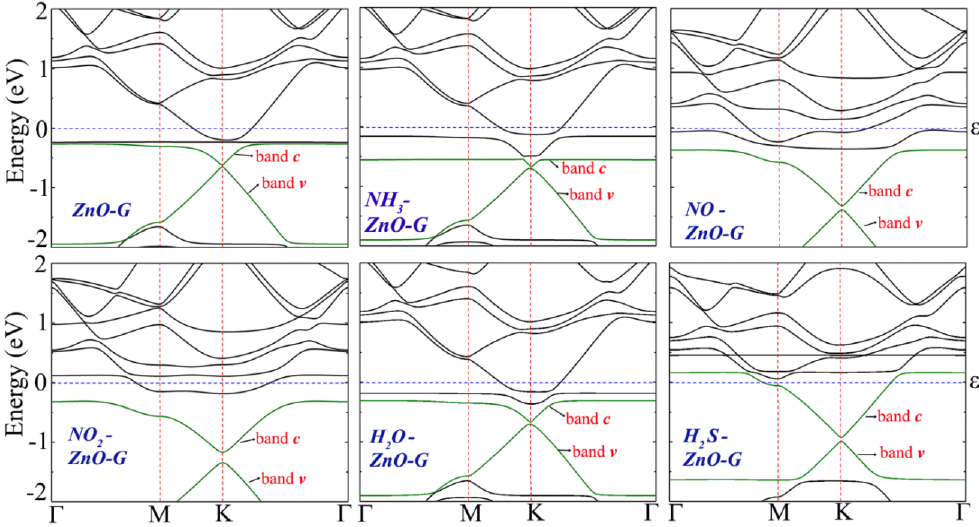
Figure 4. The electronic total charge densities of the ZnO–graphene sensor before and after complexation with NH 3 , NO, NO 2 , H 2 O, and H 2 S. The gray, purple, red, blue, yellow, and white balls represent C, Zn, O, N, S, and H atoms, respectively.